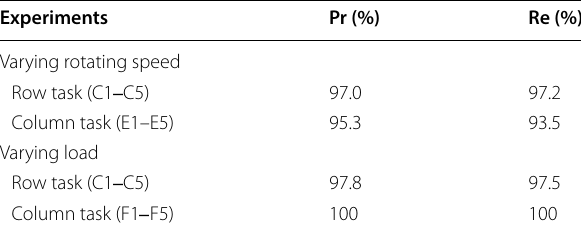
Table 7 Evaluation indexes of modified